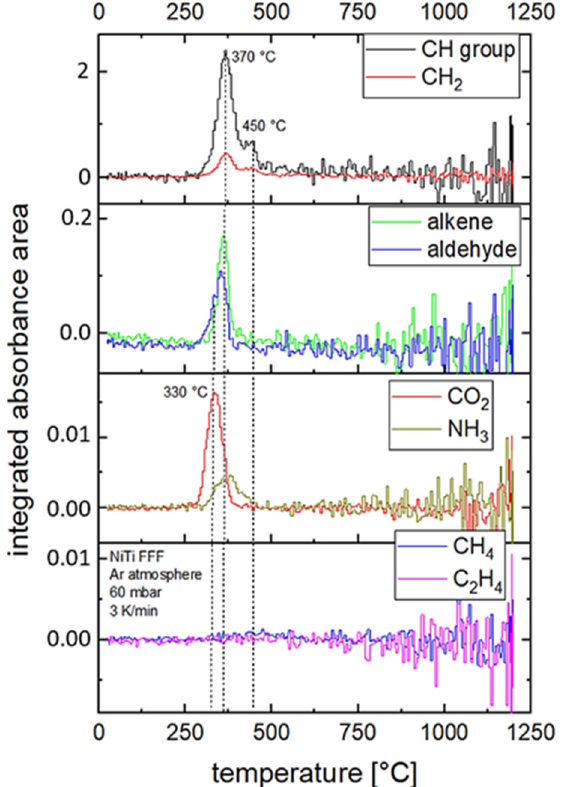
Figure 6. Gas phase analysis of printed FFF samples during heat treatment with argon at 3 K/min up to 1200 °C. The graphs show the integrated absorbance area of the respective gas species from the light spectrum (FTIR analysis) after the light beam has passed the furnace.